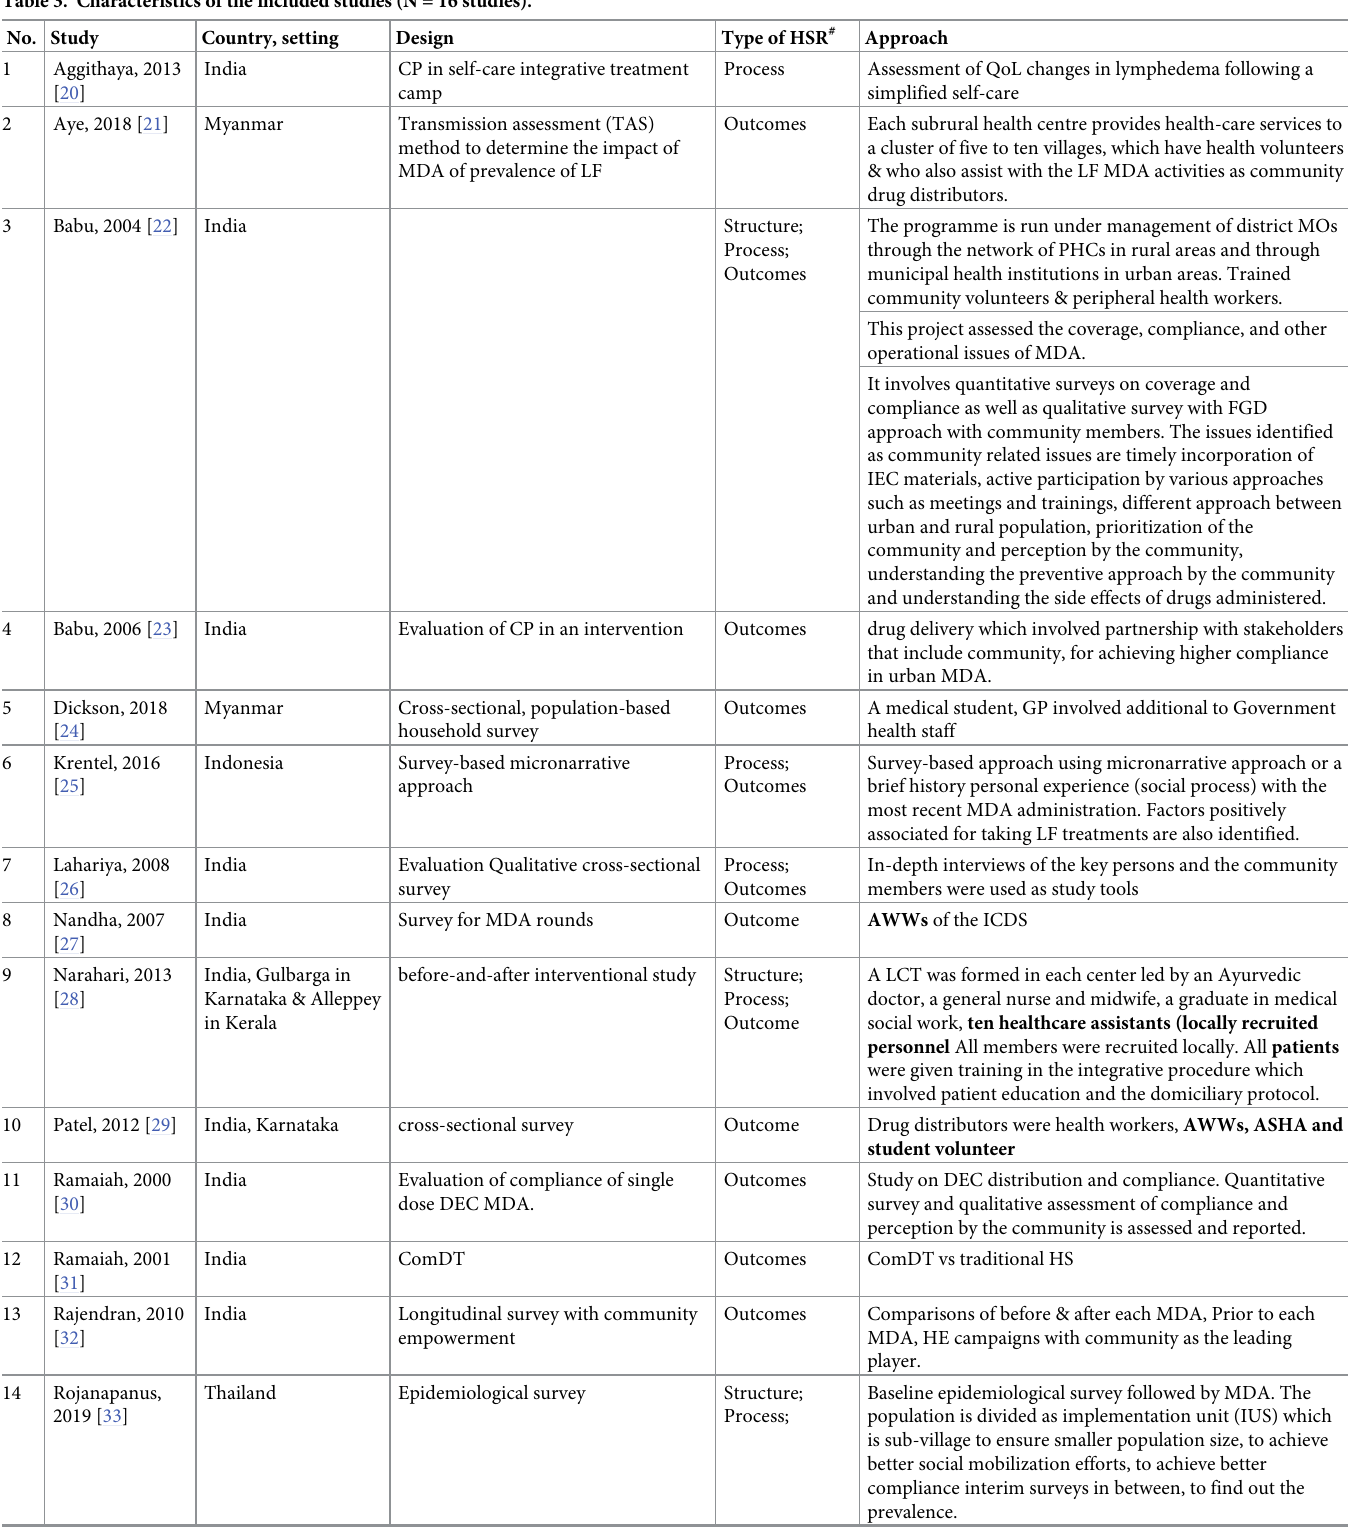
Table 3. Characteristics of the included studies (N = 16